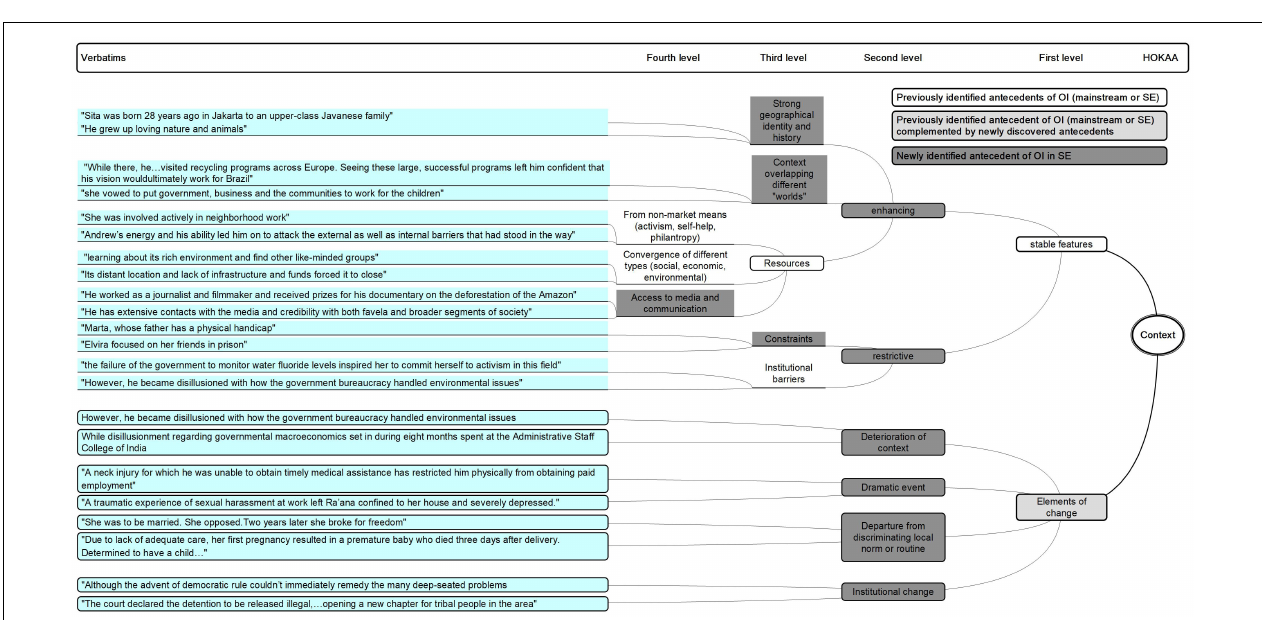
FIGURE 1 | Classification of the top-20 emerging themes into the HOKAAs. The size of each area is weighted by the number of occurrences of each theme in the text.